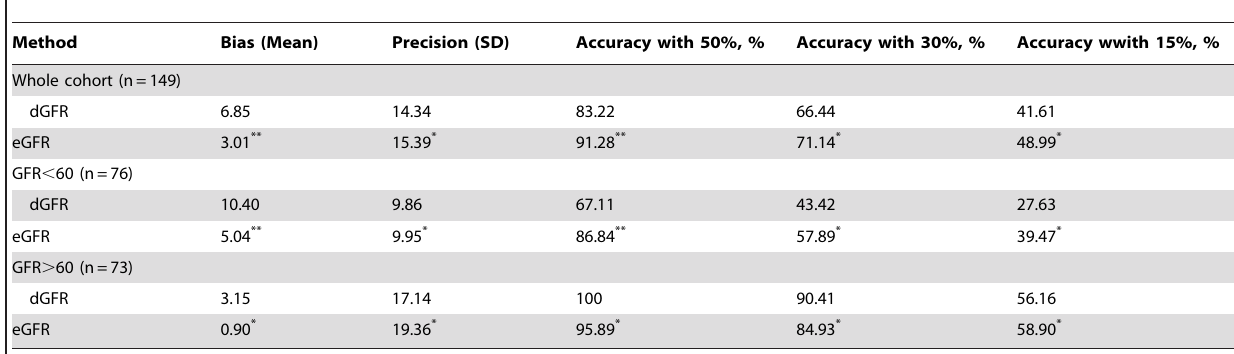
Table 1. The comparison of the dynamic renal imaging method and the CDK-EPI equation on the performance in estimating GFR.